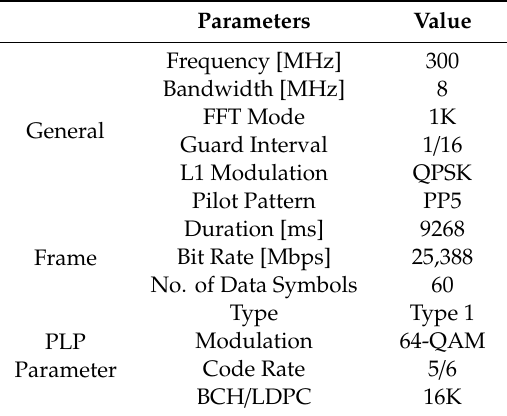
Figure 15. Test environment for the proposed DVB-X2 receiver. Table 5. Test parameters. Table 3. Implementation results for the DVB-X2 receiver engine.